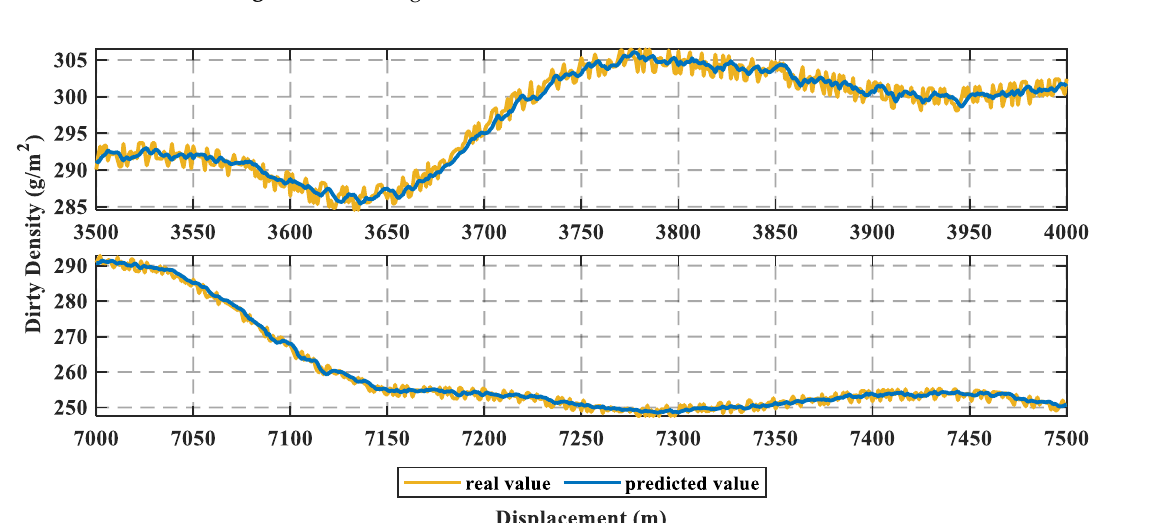
Appl. Sci. 2021 , 11 , x FOR PEER REVIEW